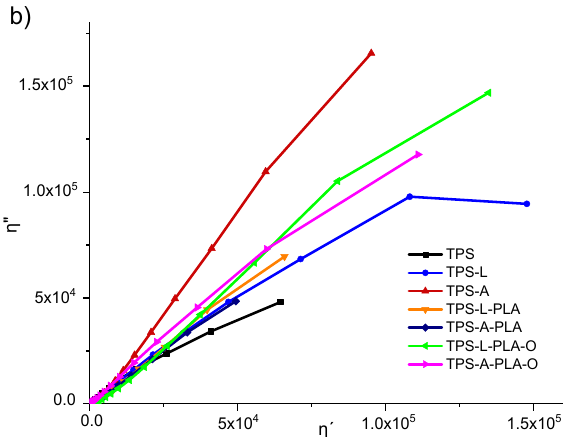
Figure 3. Rheological characteristics: ( a ) complex viscosity and ( b ) Cole–Cole diagrams of TPS blends.